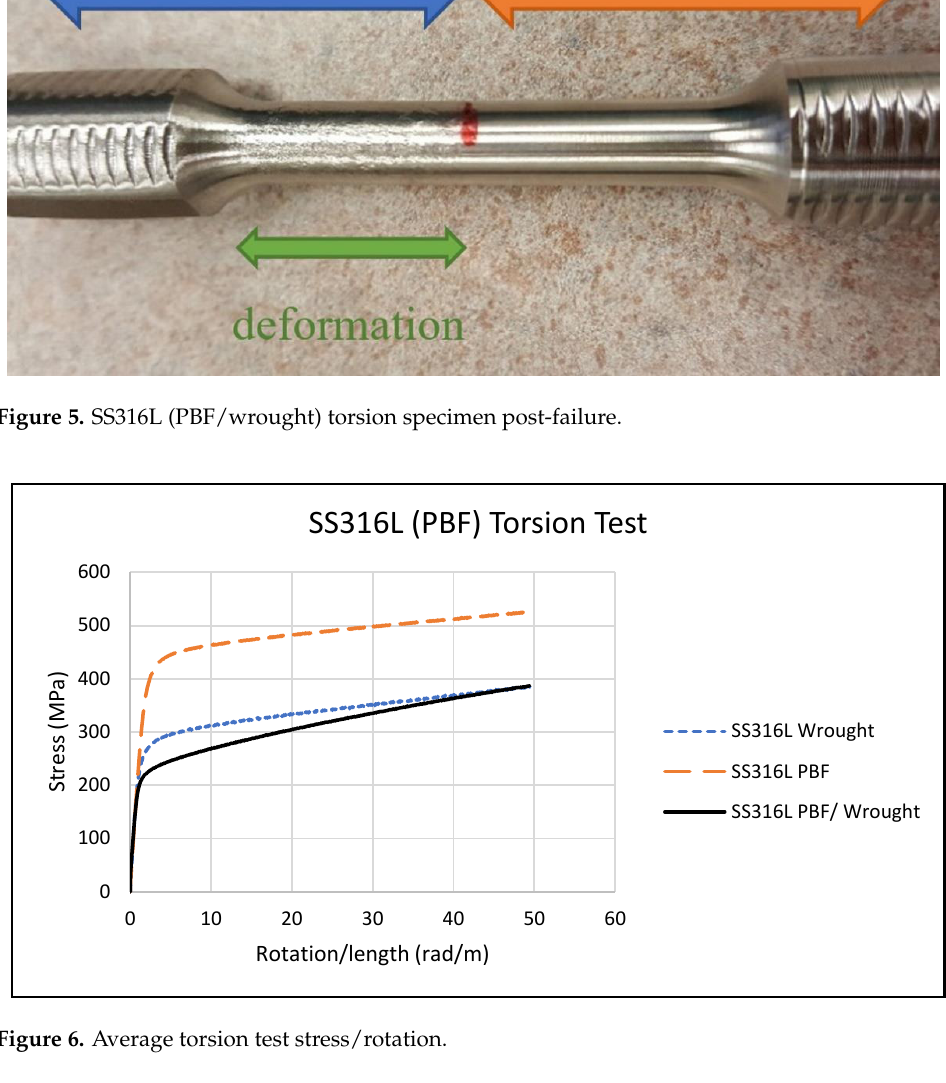
Figure 5. SS316L (PBF/wrought) torsion specimen post-failure.